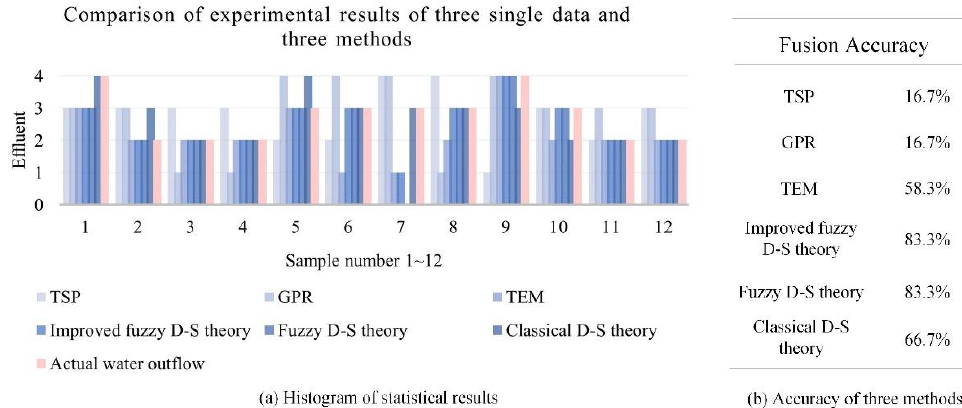
Figure 12. Three methods to predict the water output of 12 sections.